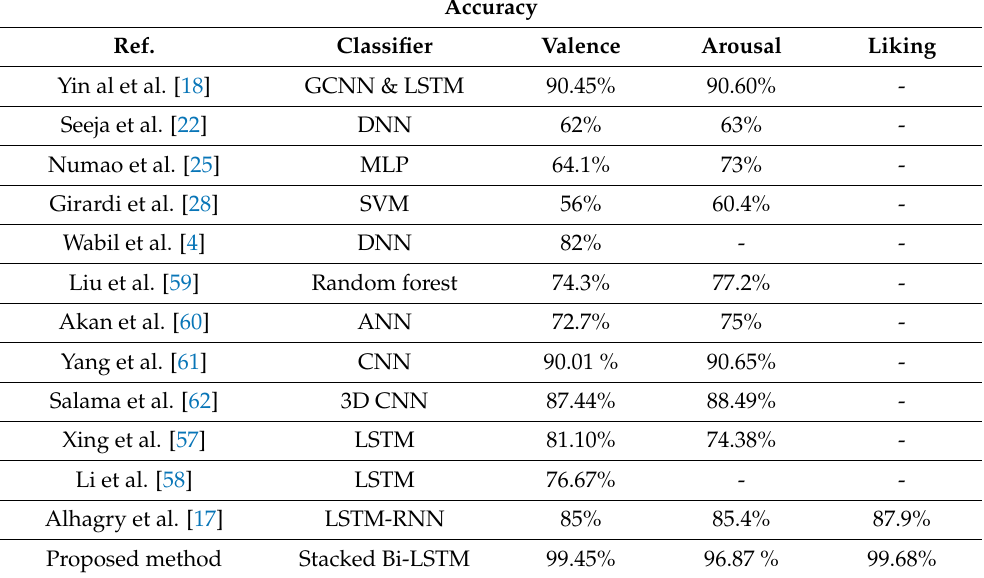
Table 8. Comparison between our classification result and the results of previous